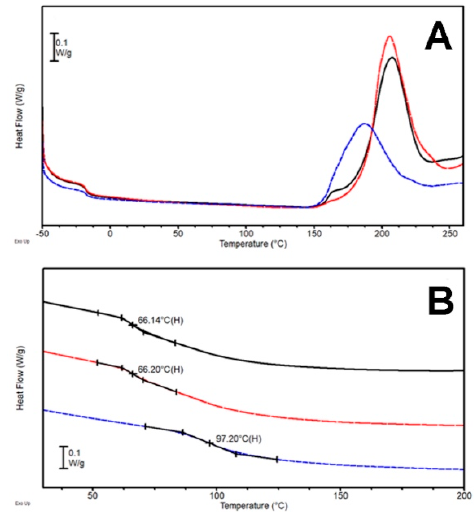
Figure 2. ( A ) DSC first heating scan (heating rate 5 °C/min), and ( B ) second heating scan (heating rate 20 °C/min) of DTA-1 ( −−− ), DTA-2.5 ( −− −− −− ), and DTA-5 ( − − − ).